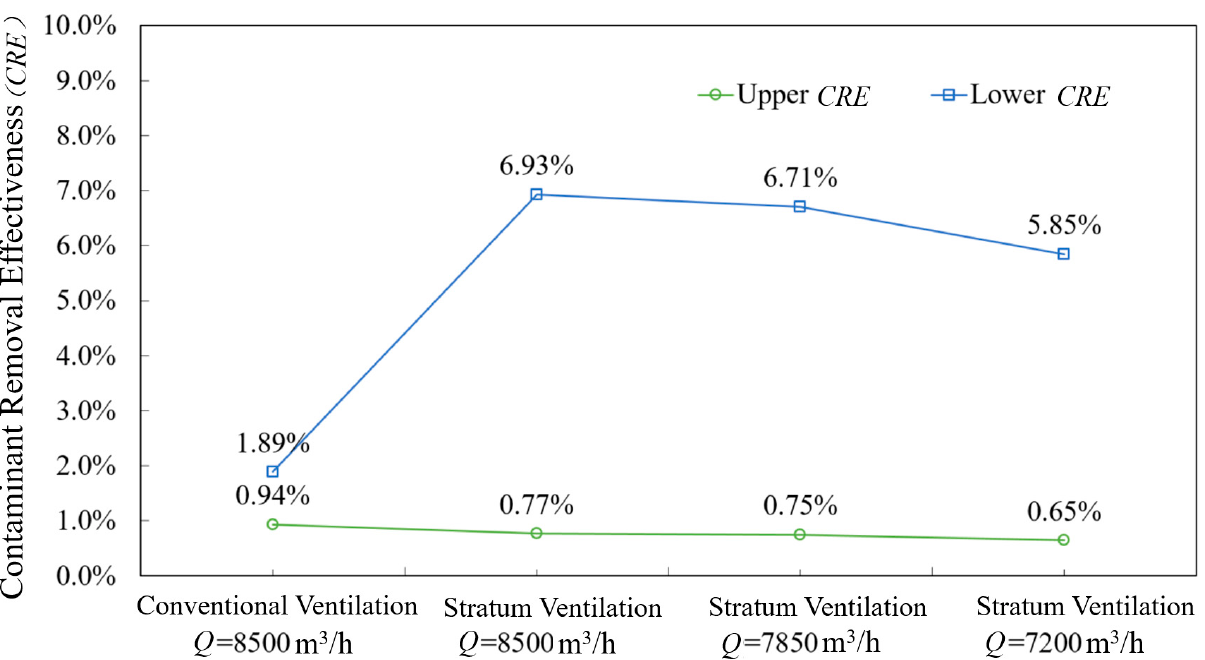
Figure 7. Comparison of contaminant removal between the two ventilation methods (CV and SV).